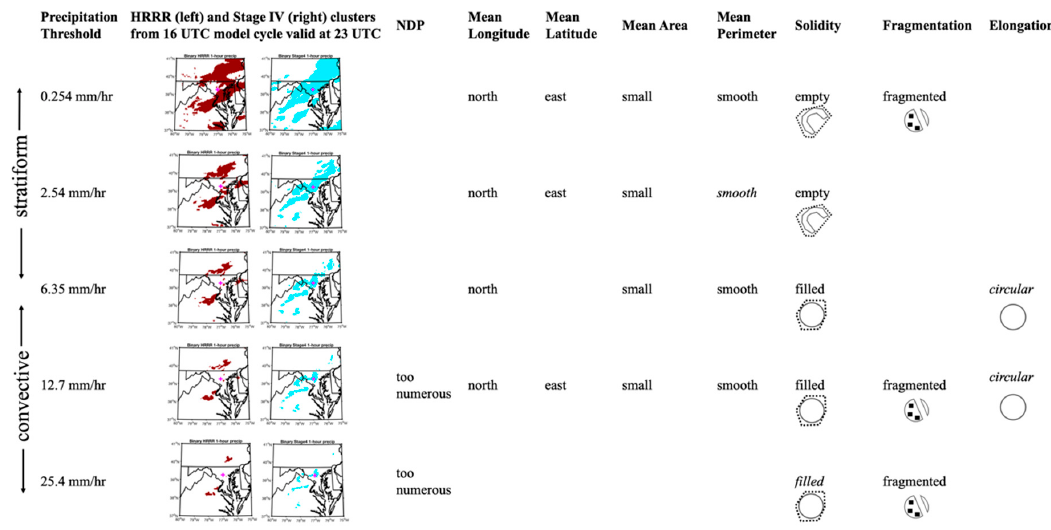
Figure 7. Summary of significant ( p < 0.1) biases in HRRR model forecast relative to Stage IV observations for the 30 July 2016 case study. To illustrate the biases, the 16 UTC model forecast and observations valid at 23 UTC are provided for each precipitation threshold. Consistent biases (identified over multiple model cycles) are in normal font and more intermittent biases (identified in one or two model cycles) are in italicized font.